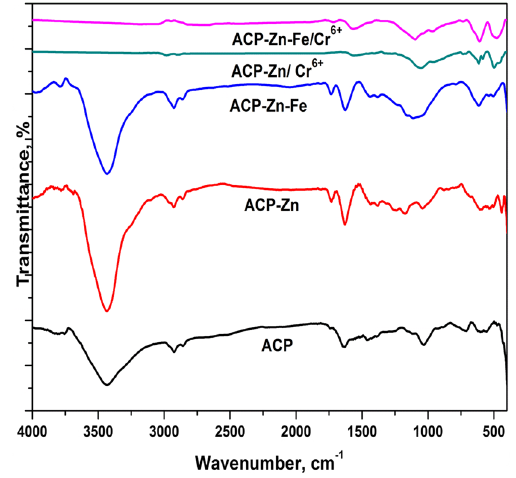
Fig. 1 FTIR spectra of the prepared samples before and after adsorp- tion of Cr(VI)